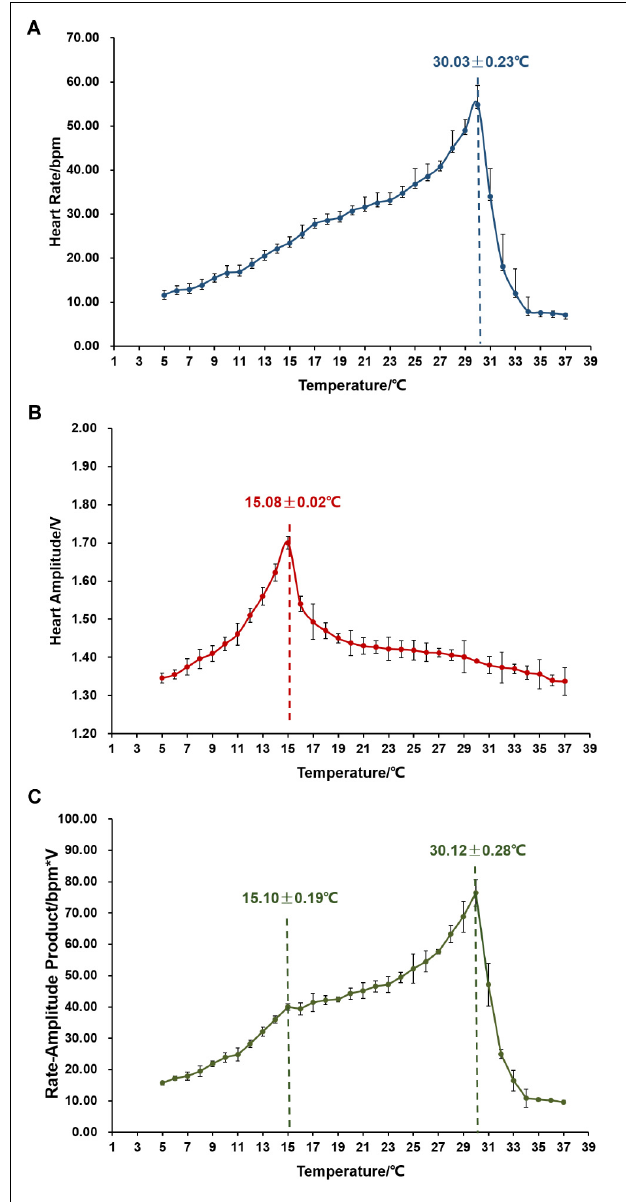
FIGURE 3 | The effect of temperature on cardiac activity ( N = 24). (A) Effects of environmental temperature on scallop HR. The vertical line indicates Arrhenius break temperature (ABT). (B) Variations in HA in response to temperature elevation. The vertical line indicates the turning temperature when HA reaches the maximum. (C) Changing patterns of RAP with temperature elevation. The vertical line indicates the two peaks in RAP